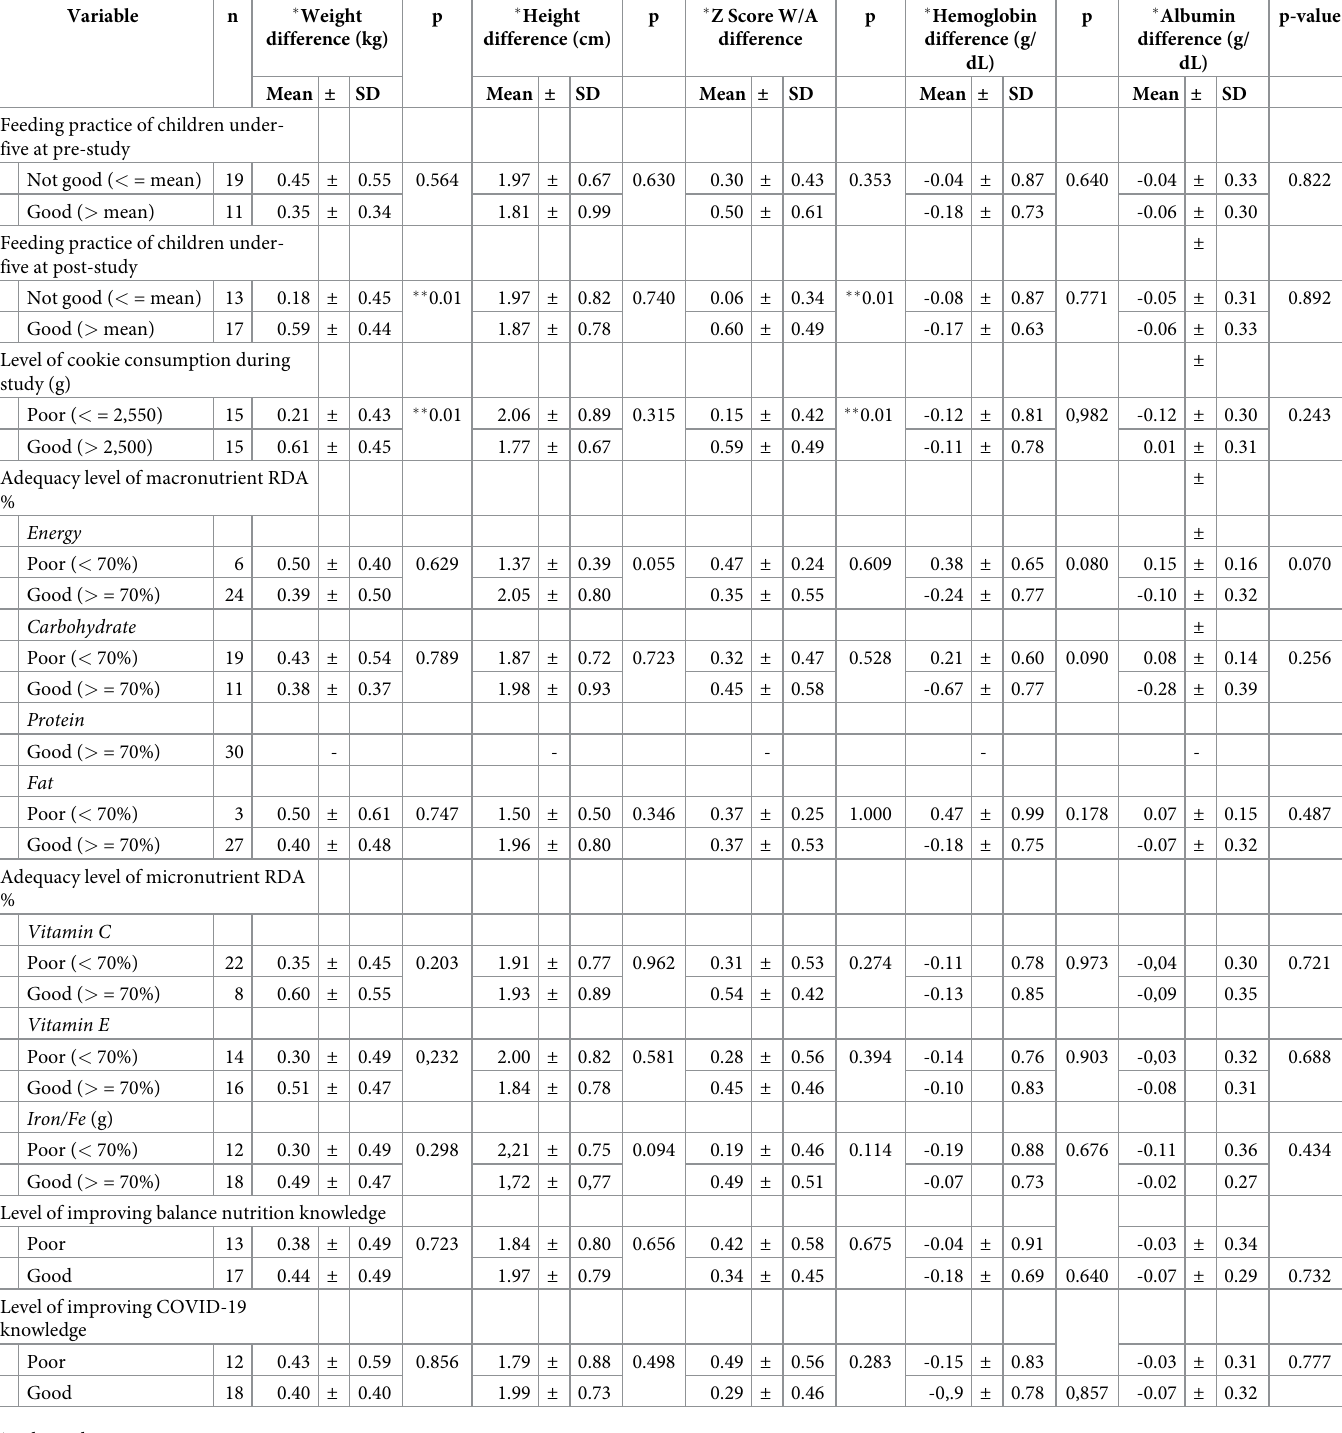
Table 4. Changes in weight, height, and Z-scores W/A based on socio-demographic characteristic, feeding practices, cookies consumption rate, adequacy level of % RDA for macro-micro nutrients, knowledge of balanced nutrition, and knowledge on COVID-19 at the end of